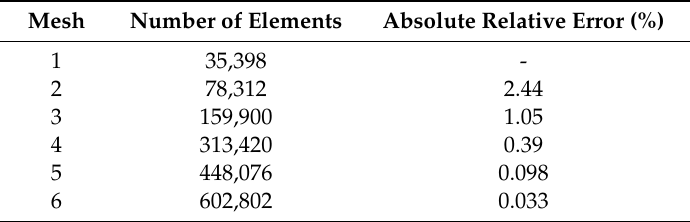
Figure 9. Mesh convergence analysis for the Mean Inlet Flow Rate for the six mesh configurations. Table 5. Relative error for the evaluated mesh configurations. The studied parameter for convergence was the Mean Inlet Flow Rate.